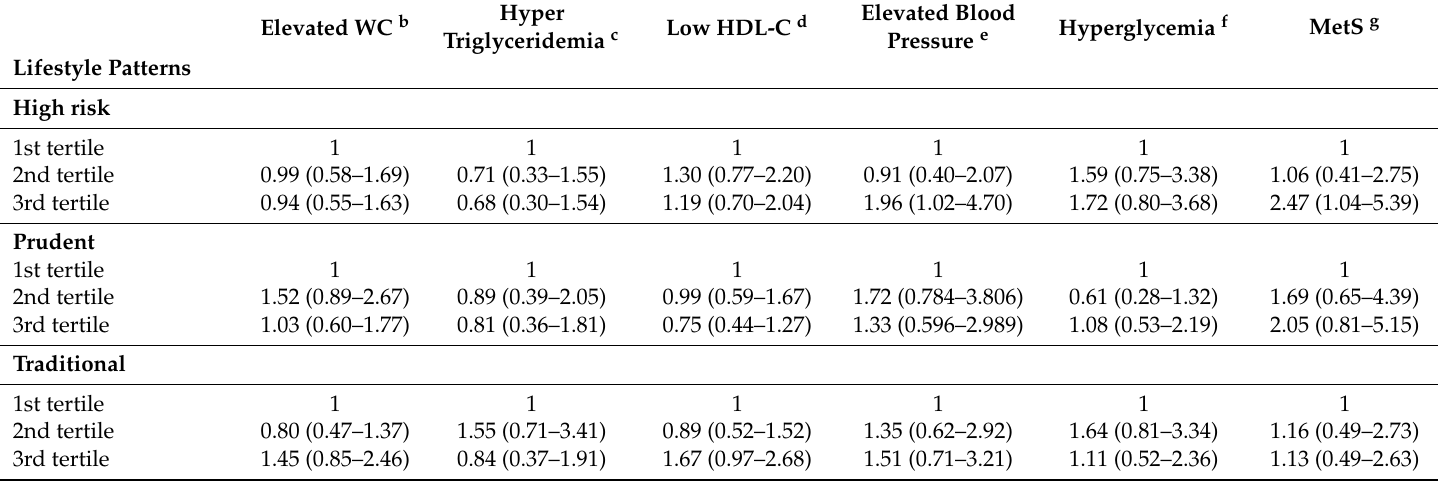
Table 4. Odds of the metabolic abnormalities and MetS across tertiles of factor scores assessed by multivariate logistic regression a in the study population ( n =